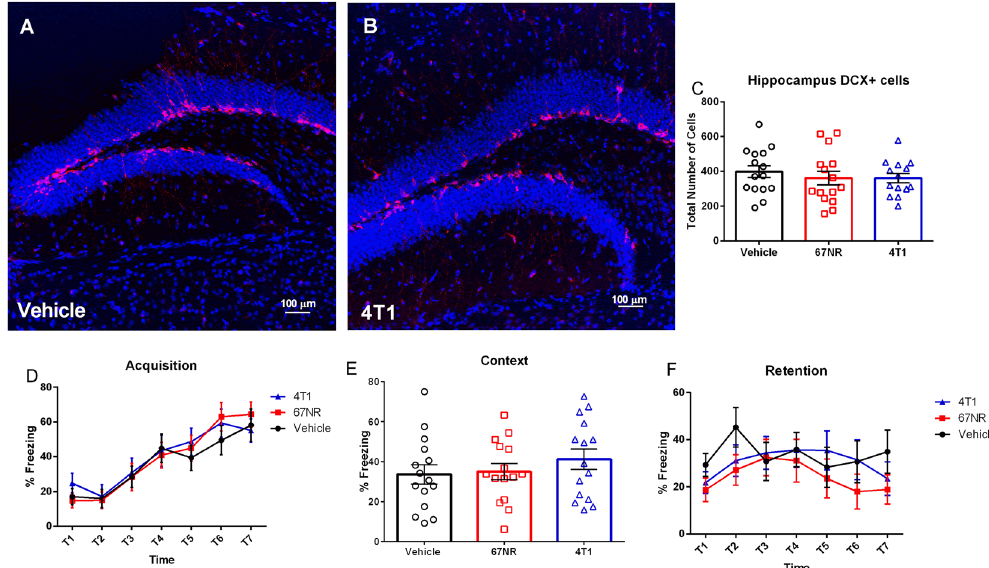
Figure 7. Learned Fear and Neurogenesis are not Altered by Mammary Tumors. ( A , B ) Representative IHC Staining of neurogenesis in the dentate gyrus of the hippocampus vehicle and 4T1 treatment groups (DCX in red and DAPI in blue). ( C ) Mean number of DCX + cells in the subgranular zone of the dentate gyrus. There were no significant differences in the number of DCX + cells. ( D – F ) Acquisition, context, and retention phases of fear conditioning testing. There were no significant differences in acquisition, context, and retention during fear conditioning. The measures and tissues were collected 18–20 days after tumor cell or vehicle inoculation (n = 12–15/group). The data are presented as mean + SEM. Graph bars that do not share a letter are statistically significant different at p <